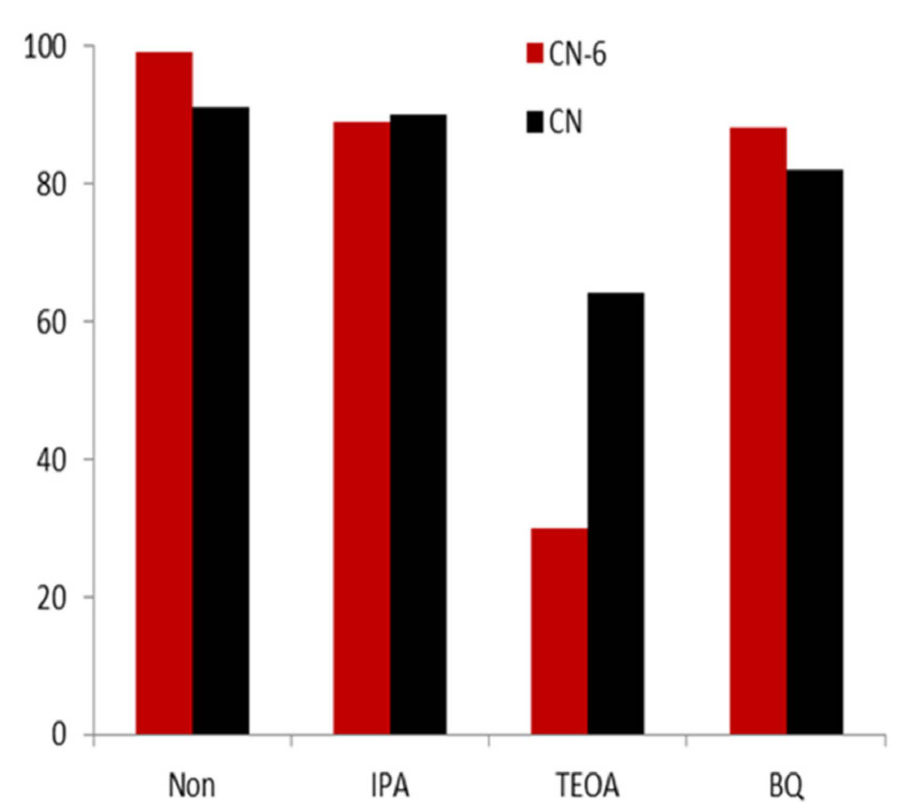
Figure 10. The trapping experiment of the active species during the photocatalytic degradation of RhB relative to CN-6 under visible light